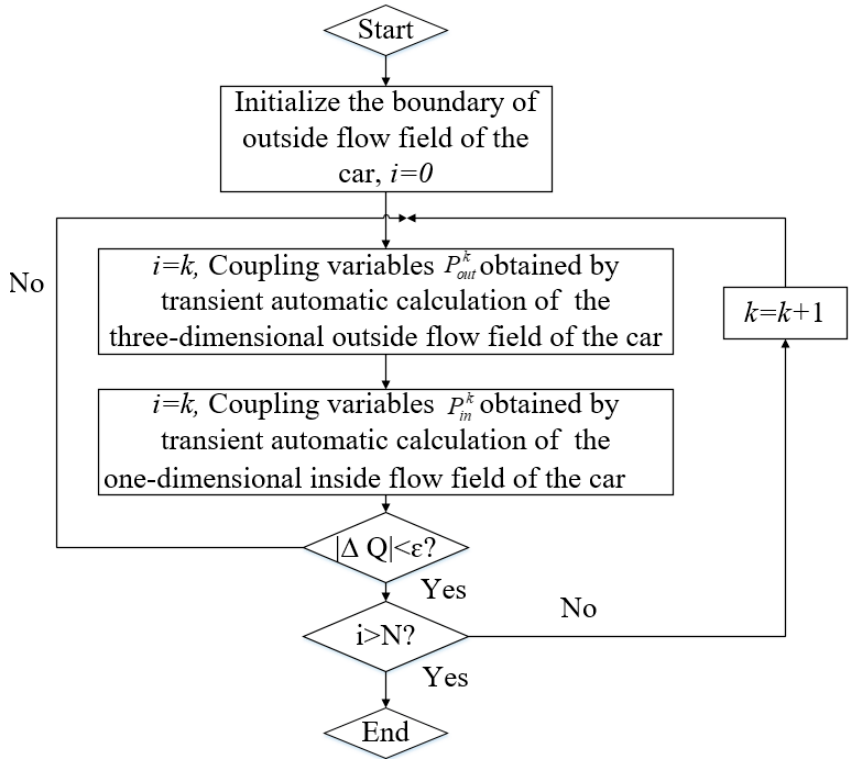
Figure 2. Calculation process of the transient coupling.